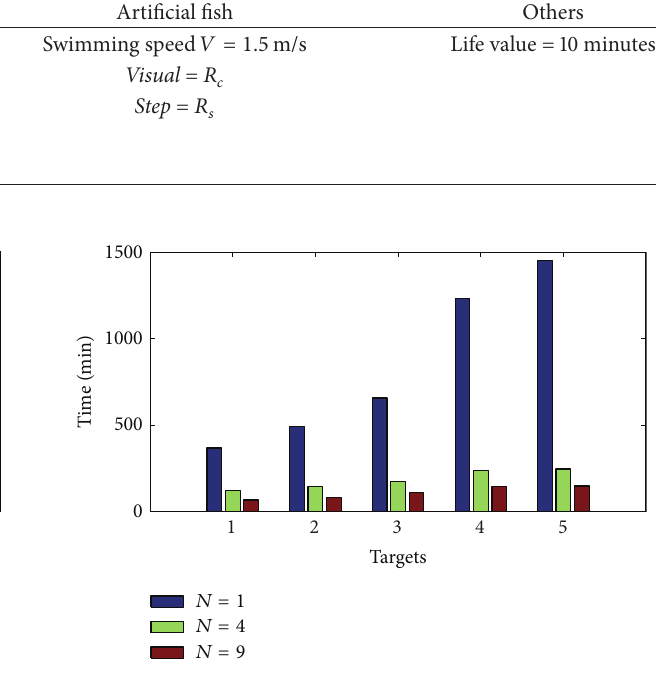
Figure 11: Target discovery